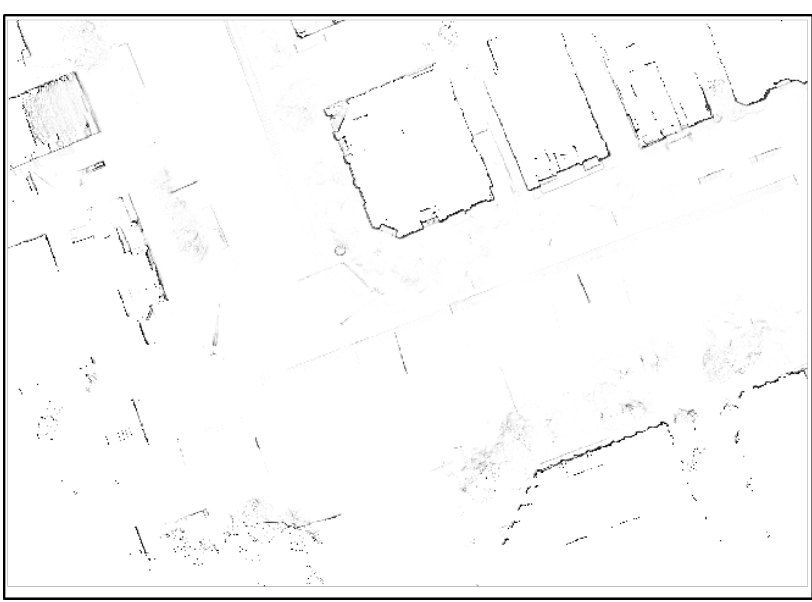
Figure 15. Probabilistic occupancy grid map generated by applying the IEPF algorithm.